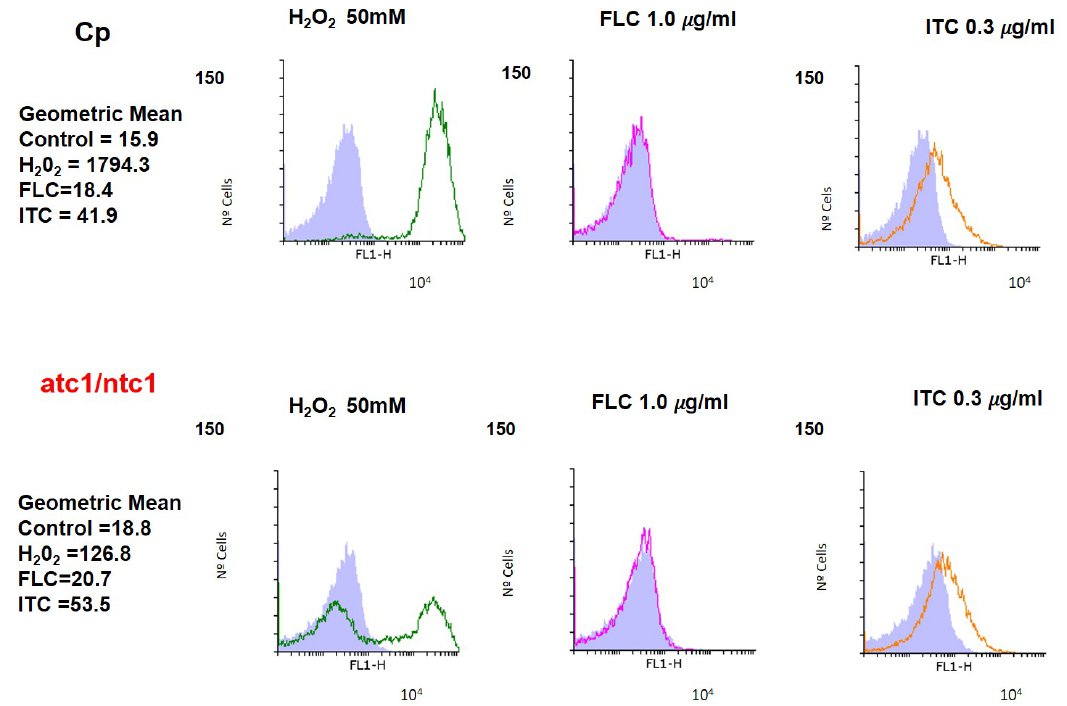
Figure 2. Endogenous ROS formation after the addition of FLC (red histograms) and ITC (orange histograms). Exponential yeast-like cells of the two C. parapsilosis strains were grown in YPD medium overnight, resuspended in PBS buffer, and then treated with the two antifungals for 1 h at 37 ◦ C. H 2 O 2 50 mM (green histograms) was introduced as a positive marker for oxidative stress. The samples were analyzed with dihydrofluorescein (DHF) by flow cytometry as described in Methods. Control assays correspond to the gray area, and identical aliquots were treated with 1.0 µ g/mL FLC and 0.3 µ g/mL